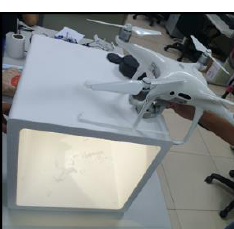
Figure 1. Use of alternative lightbox as an integrating sphere in calibration.